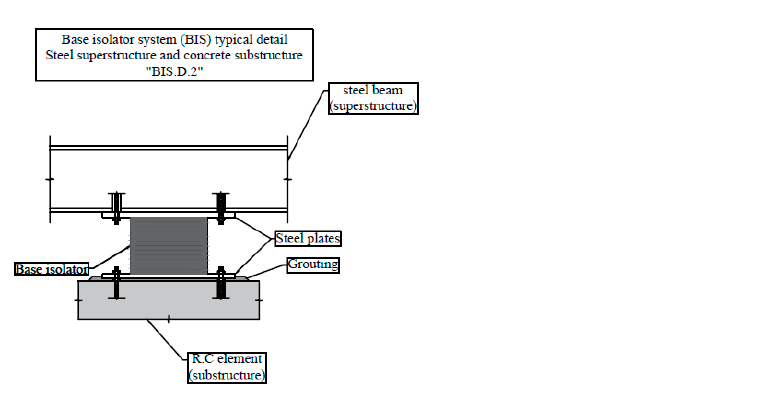
Figure 9. Base isolator system attachment to steel superstructure and concrete substructure—typical detail (after [20,32,33]).